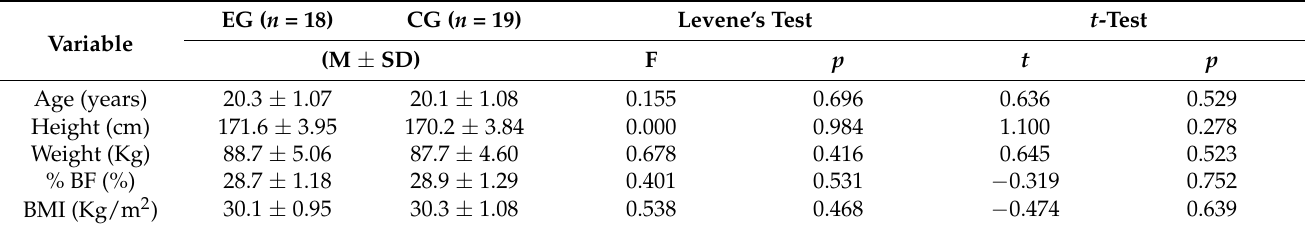
Table 1. Participants’ physical characteristics and homogeneity test for physical